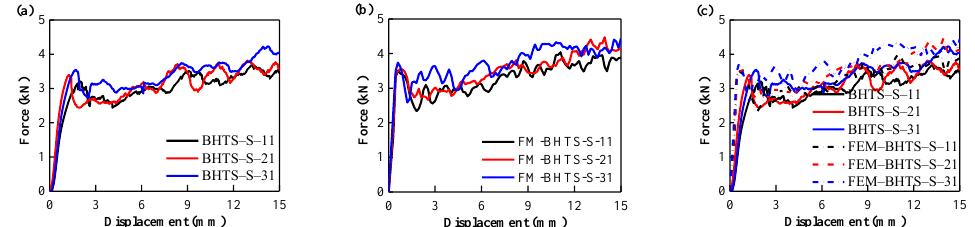
Figure 10. Typical response curves of BHTS – S at each strain rate: ( a ) curves of experimental; ( b ) curves of FEM; ( c ) comparison between experimental and FEM.